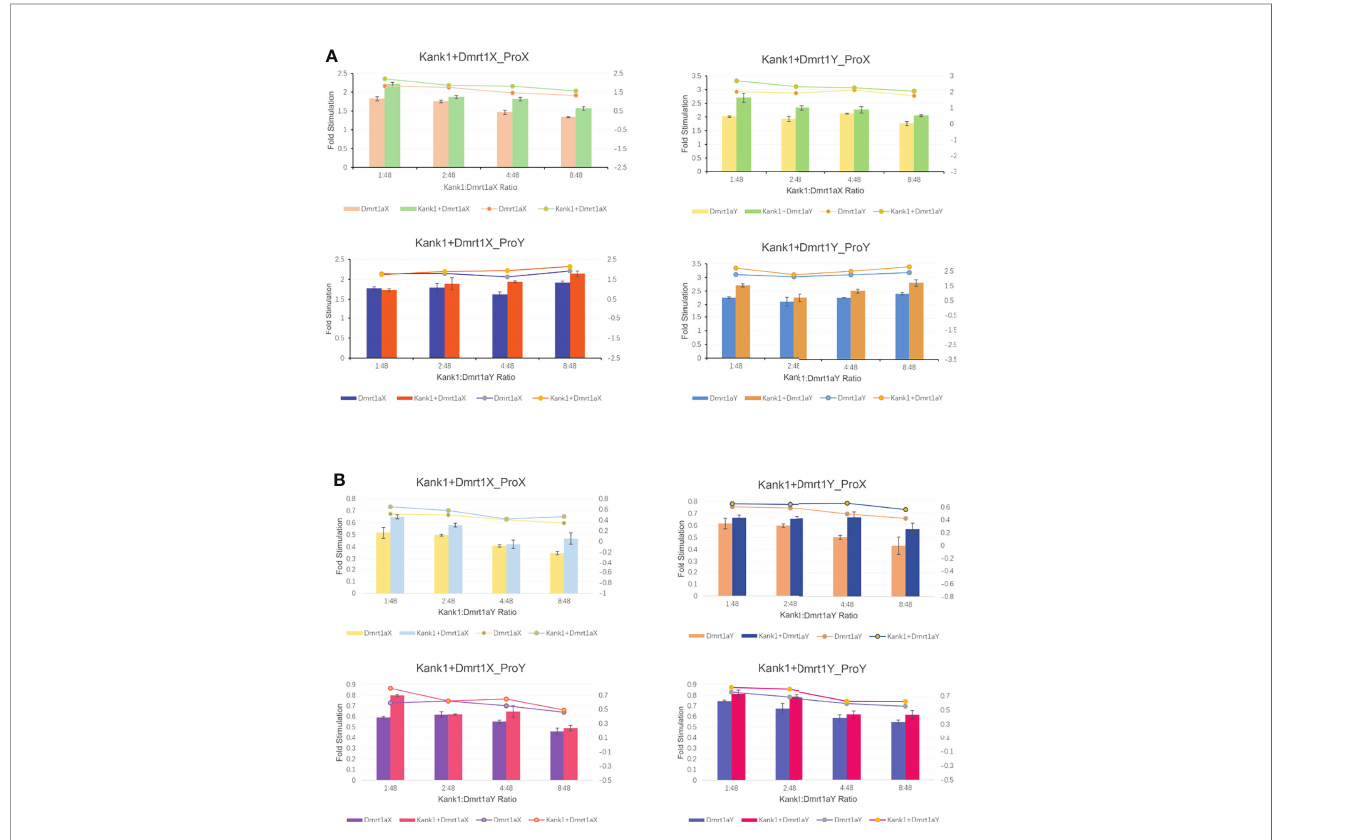
FIGURE 9 | The result of dual-luciferase reporter assay in CHO cells (A) and in 293T cells (B)